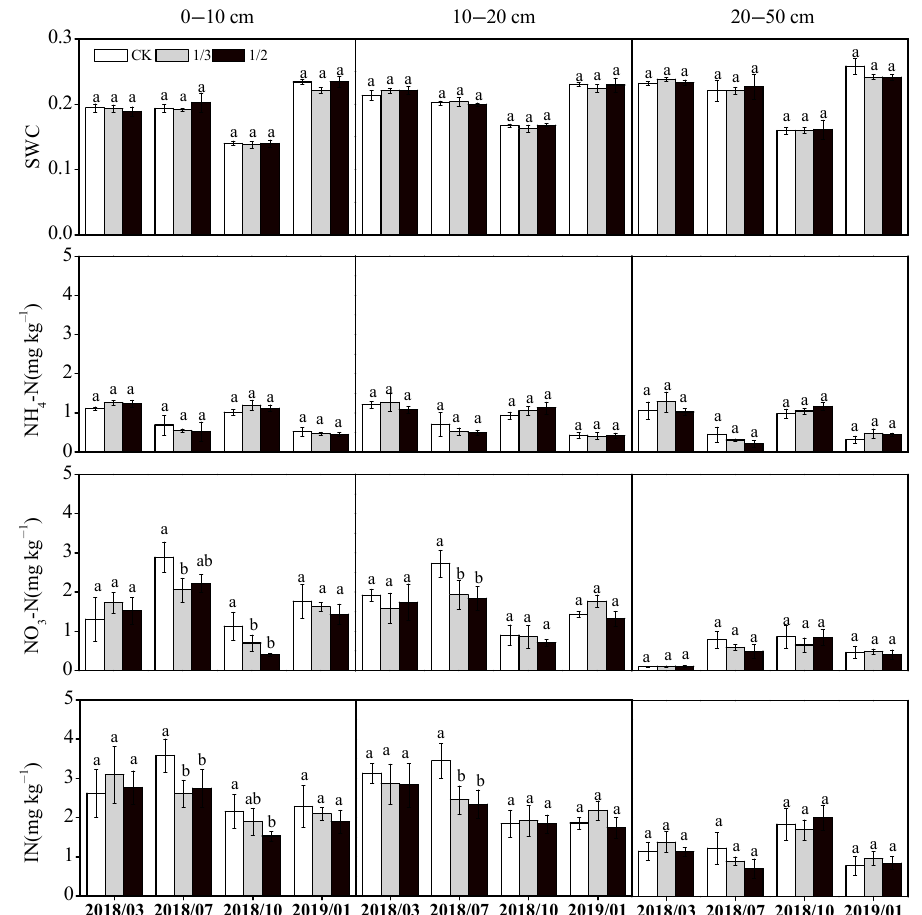
Figure 3. Dynamic changes in soil water and inorganic nitrogen contents in the poplar plantation after pruning treatments. Note: The same lowercase letter over two columns indicates no significant difference between pruning treatments at the same time point ( p > 0.05), while different lowercase letters indicate significant differences between pruning treatments at the same time point ( p < 0.05). Soil properties include soil water content(SWC), soil ammonium nitrogen (NH 4 -N), soil ni- trate nitrogen (NO 3 -N) and soil total inorganic nitrogen(IN); 2018/03, 2018/07, 2018/10 and 2019/01 represent the sampling time year/month; 0–10 cm, 10–20 cm and 20–50 cm represent different soil sampling depths. This is the same below. Table 3. F and P values for the effects of pruning treatments (T), sampling seasons (S) and soil depths (D) on the soil properties from repeated measures ANOVA.